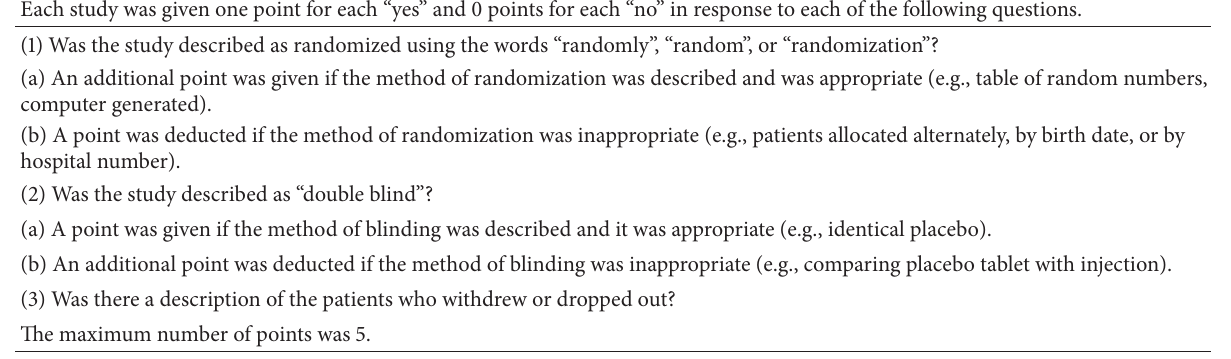
Table 1: Criteria used to grade the quality of RCTs: the Jadad scores.